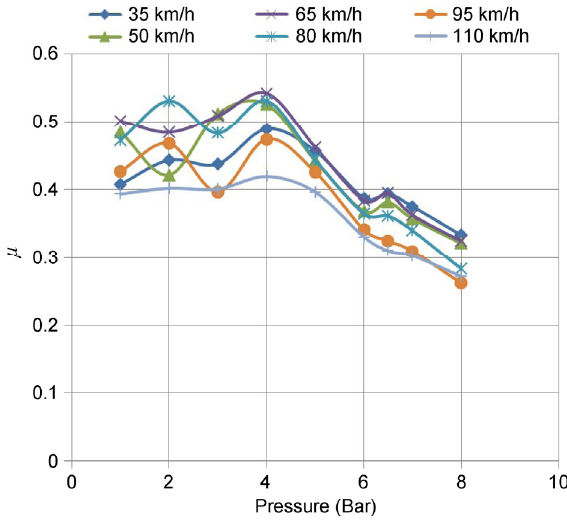
Fig. 4 Coefficient of friction (COF) vs pressure (1–8 Bar) at different speeds of the inertia wheel (35–110